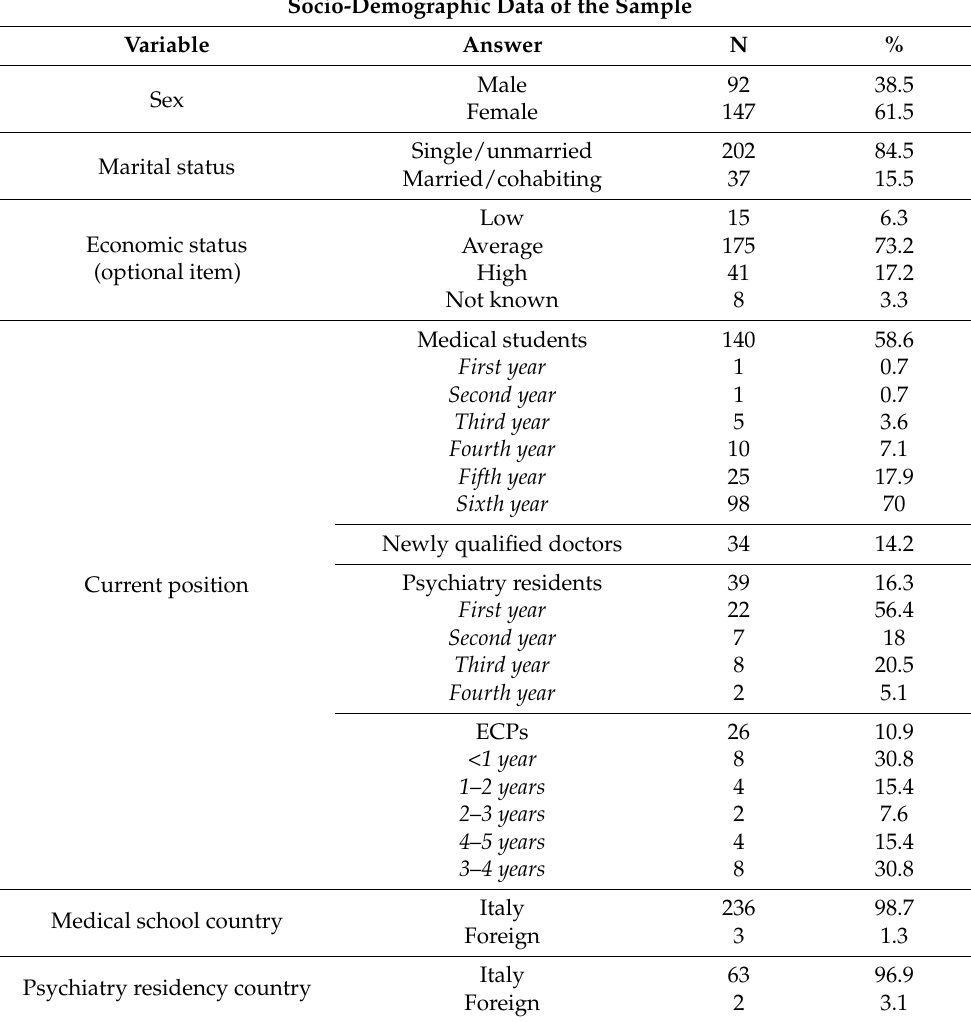
Table 1. Socio-demographic data of the sample.